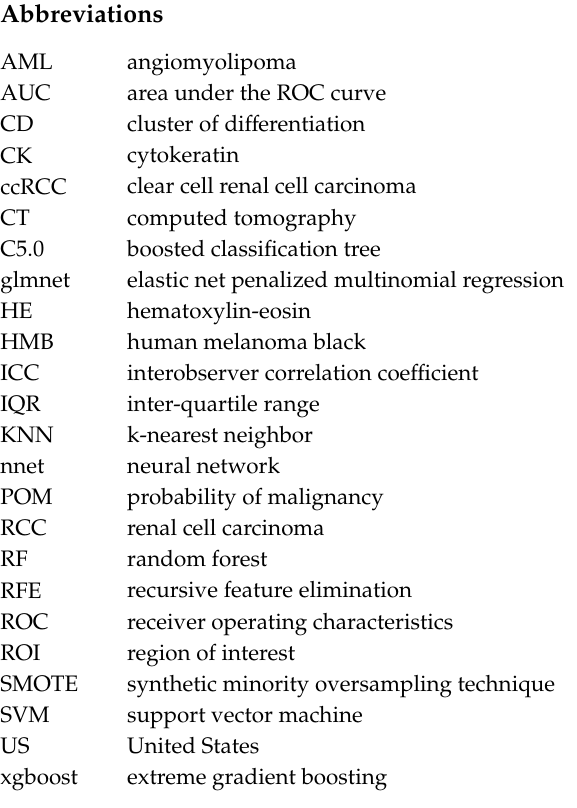
the n = 141 patients without artefacts in the CT scans, Table S8: AUC for the combinations of various machine learning models and feature selection with class weights set as inverse class probability, Table S9: Details of the evaluated radiomic features, Table S10: Details of the evaluated machine learning